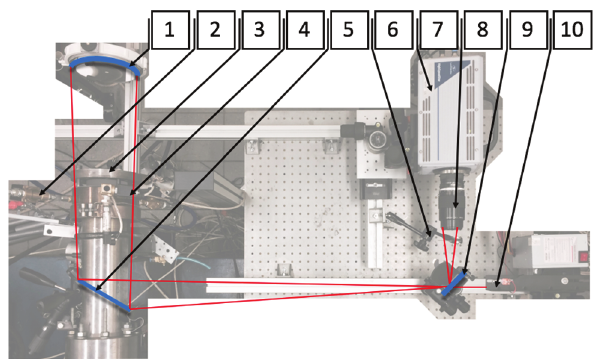
value is strictly determined by the value of a Fig. 8.